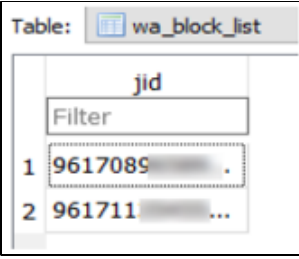
Figure 12. “wa_block_list”